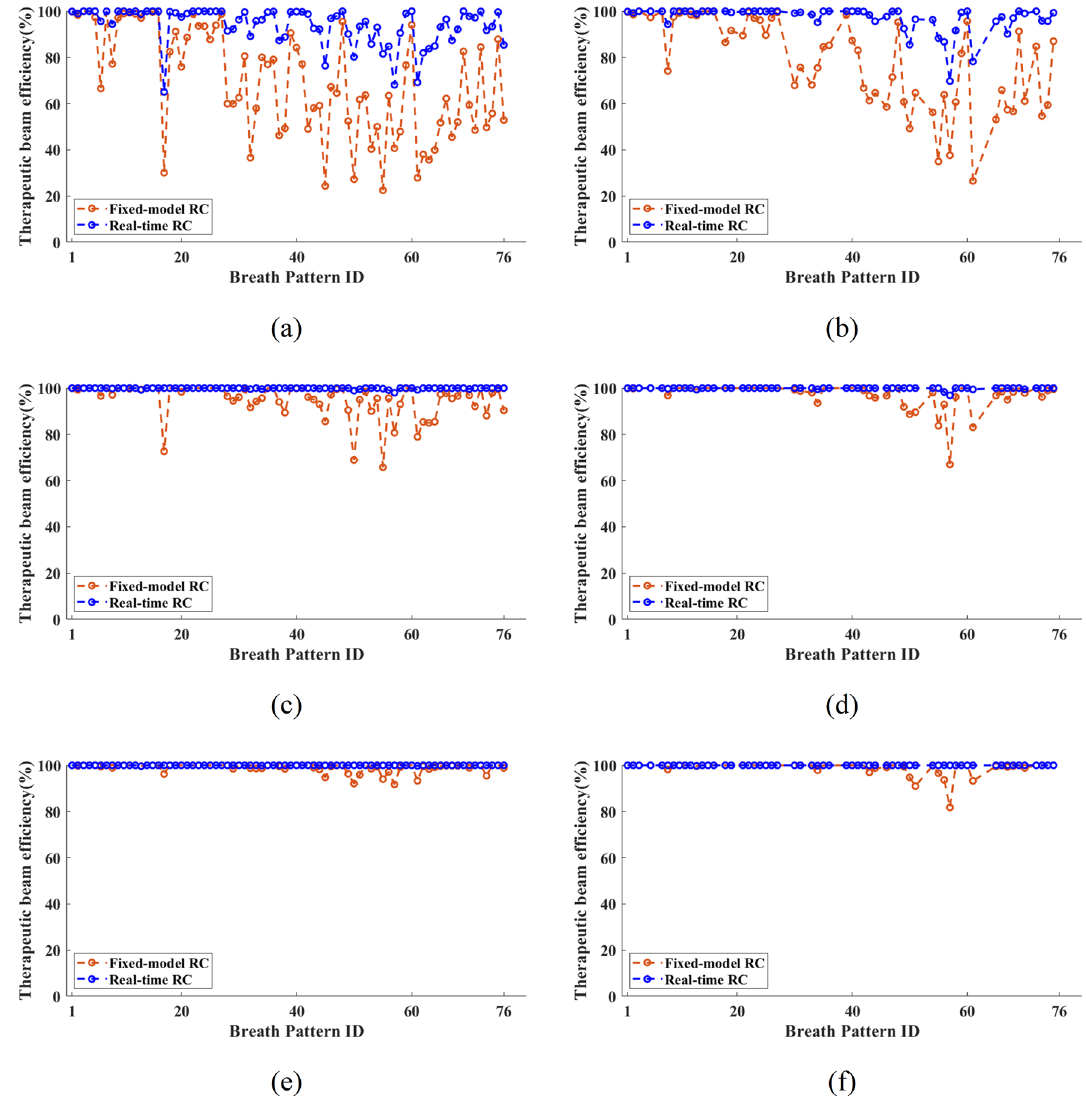
Figure 8. Comparison of the fixed-model RC and real-time RC motion prediction. ( a ) and ( b ) are for AE < 1 mm threshold; ( c ) and ( d ) are for AE < 3 mm threshold; ( e ) and ( f ) are for AE < 5 mm threshold. In ( a ), ( c ), and ( e ), the fixed-model RC uses a training length of 600 data while ( b ), ( d ) and ( f ) uses training length of 1800 (Testing conditions: N = 14 , N ′ = 12 , h p = 10, t p = 333 ms).